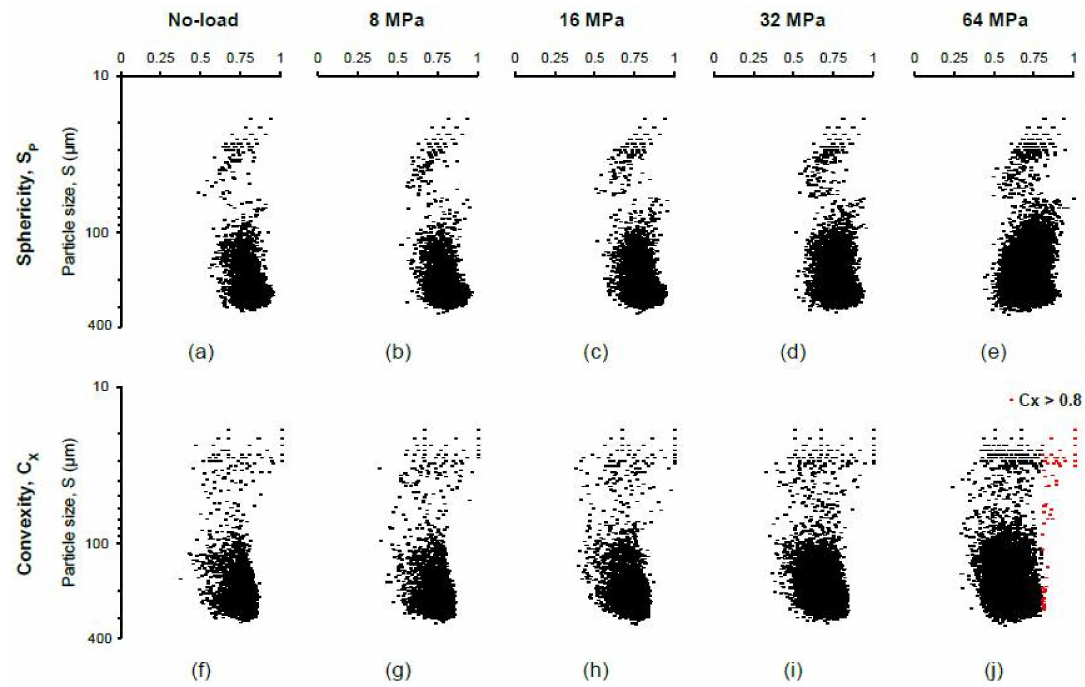
Figure 9. Shape parameters of RBS particles at different vertical stresses: ( a – e ) sphericity; ( f – j ) convexity.